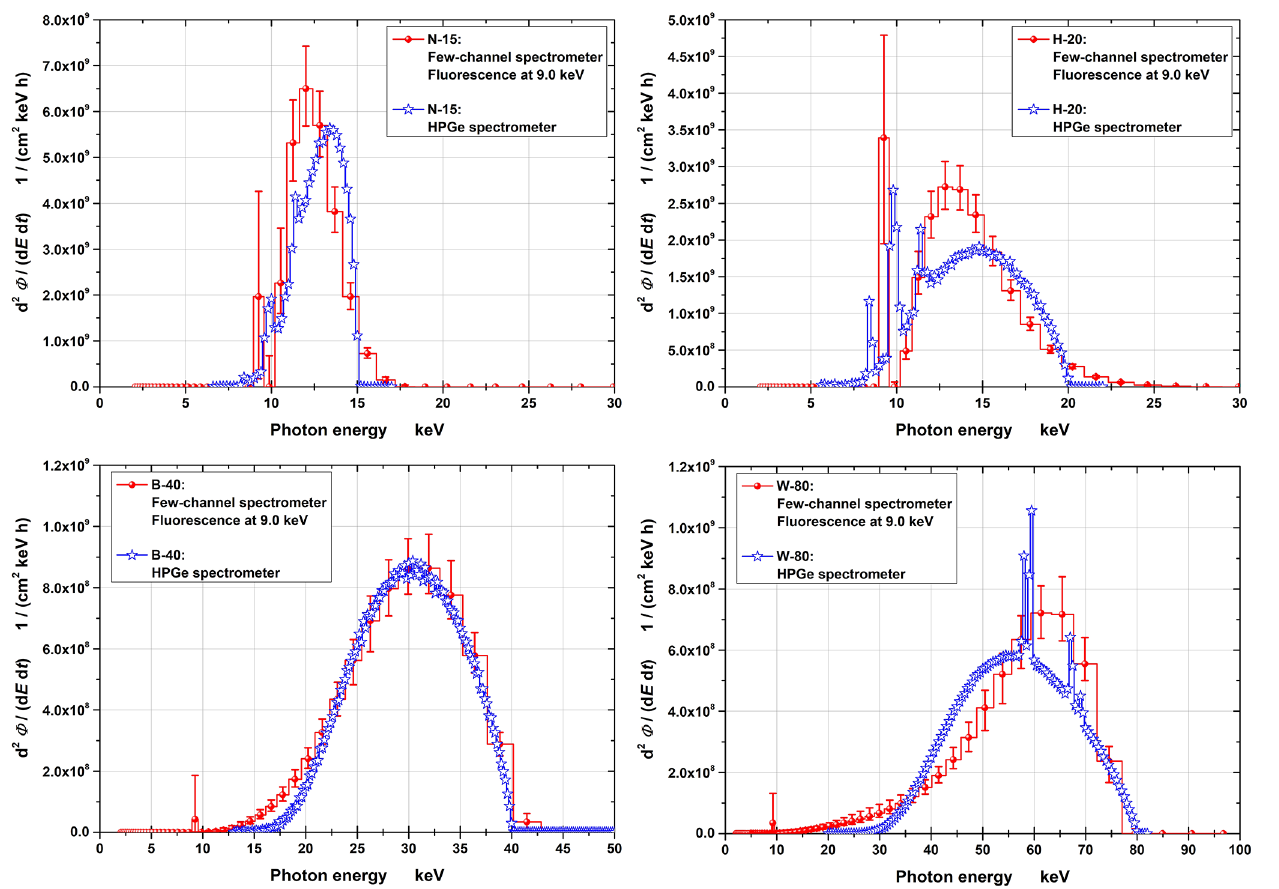
Figure 3. Comparison of the spectra measured with the few-channel spectrometer (red line) and those measured with the high-purity ger- manium spectrometer (blue lines). Meaning of the uncertainty bars: the value of the spectral fluence is usually located with a probability of approximately 95% in the assigned coverage interval. Table 1. Details of the